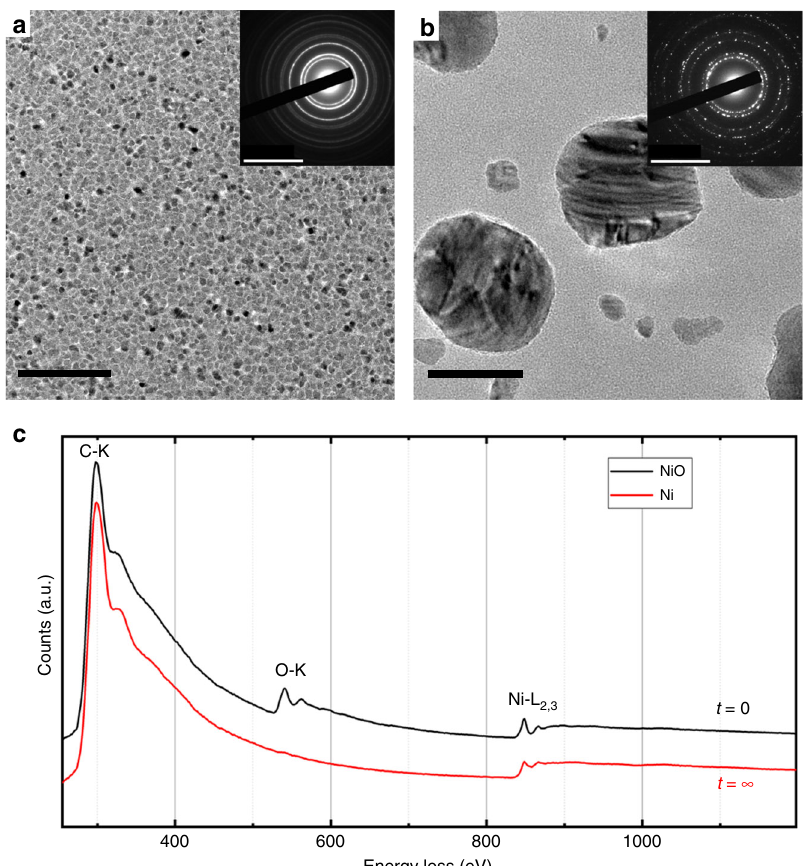
Fig. 1 Morphology and composition before and after reduction. TEM analysis in imaging, electron diffraction a , b , and EELS c of the NiO crystallites before a , c and the Ni crystals after b , c reduction, taken with a continuous electron beam from plan-view specimens. Scale bars in a , b : 50 nm in the images and (10 nm) − 1 in